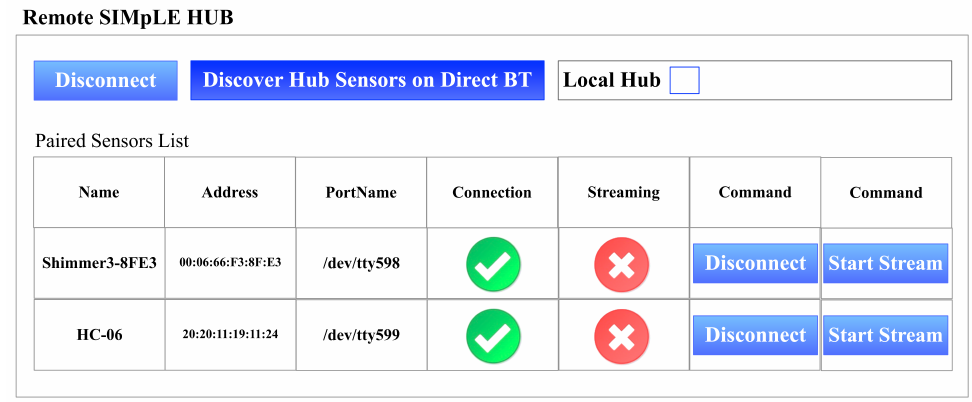
Figure 6. Sensors connected to the Remote SIMpLE